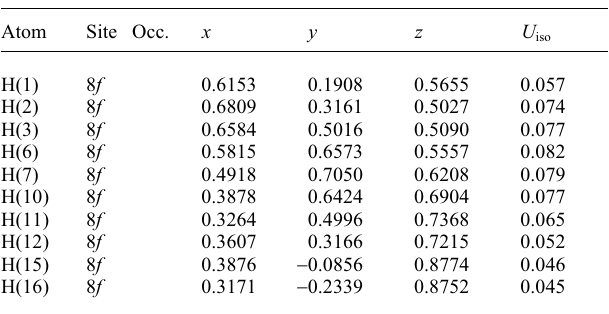
Table 2. Atomic coordinates and displacement parameters (in Å 2 )